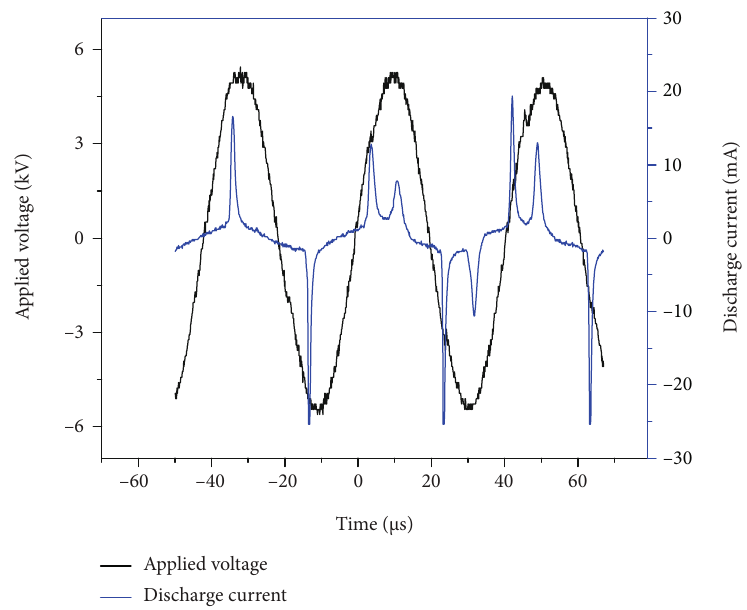
Figure 2: Current-voltage graph at gas fl ow rate Q = 3 L/min at an applied voltage of